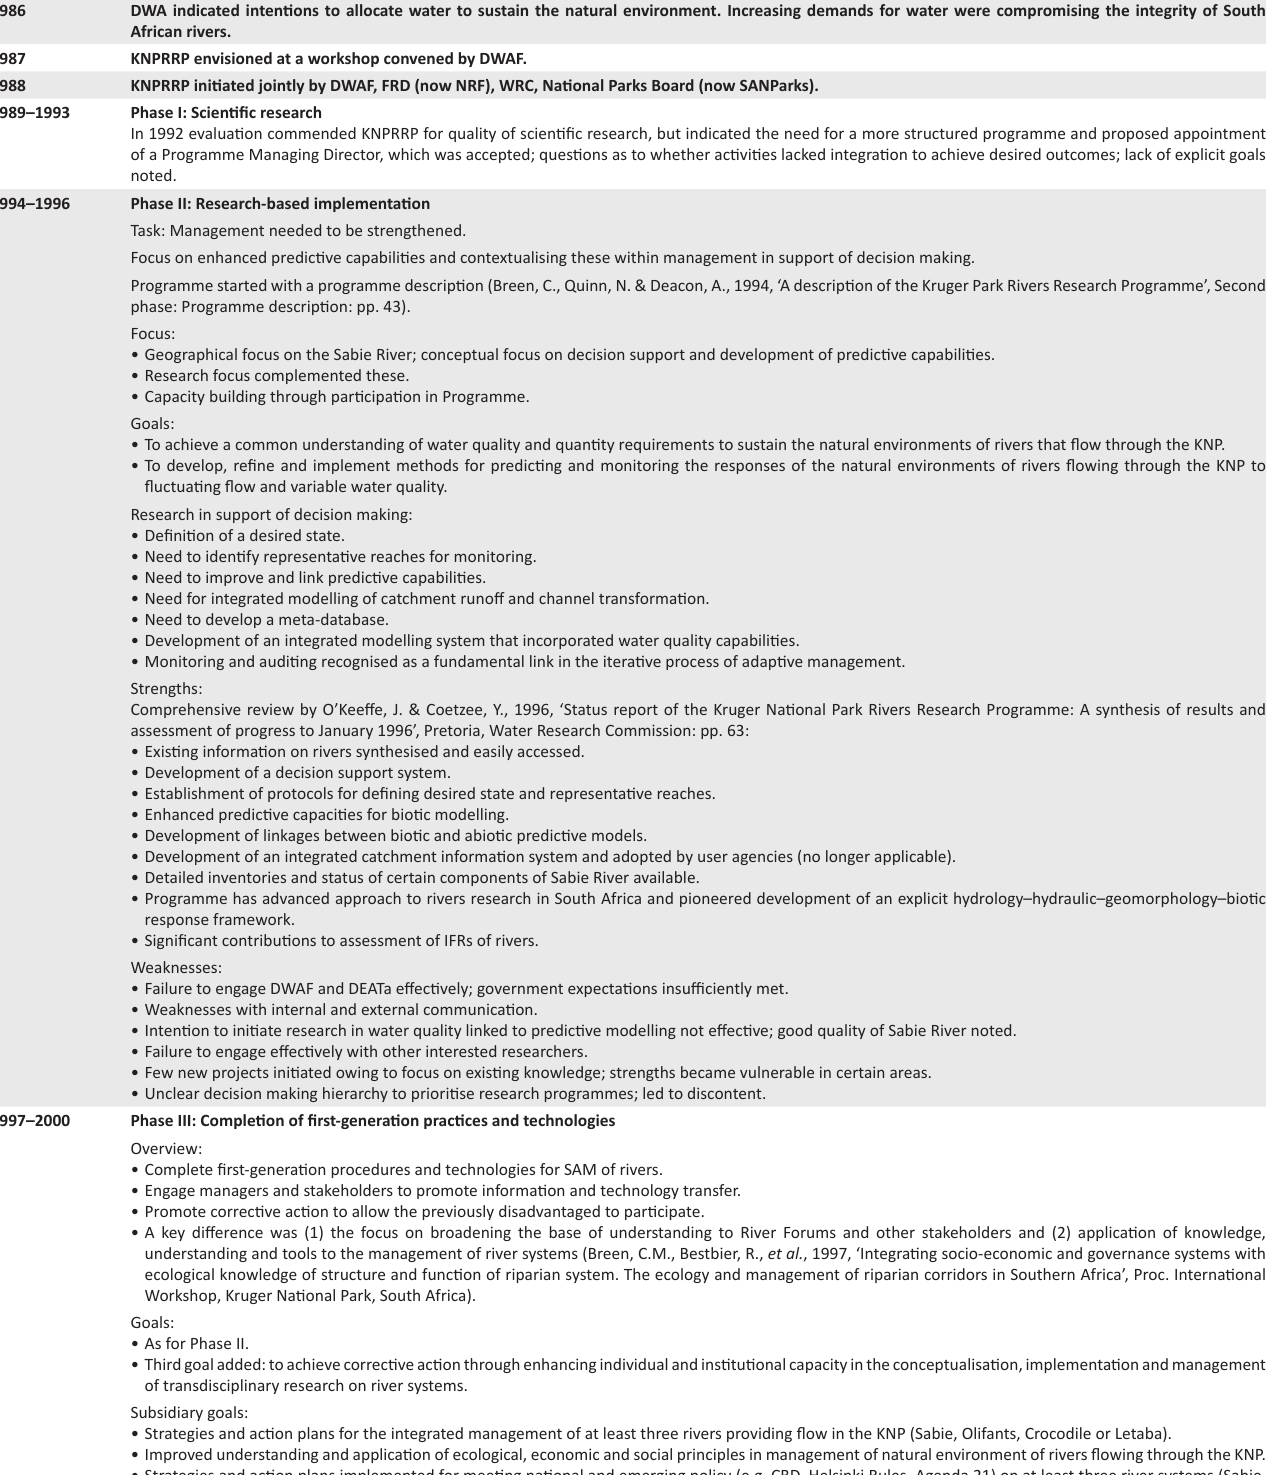
TABLE 1: Timeline of the Kruger National Park Rivers Research Programme outlining goals and focus (from Breen, C., Dent, M., Jaganyi, J., Madikizela, B., Maganbeharie, J., Ndlovu, J., et al ., 2000, ‘The Kruger National Park Rivers Research Programme’, Final report, Water Research Commission, Pretoria; O’Keeffe, J. & Coetzee, Y.,